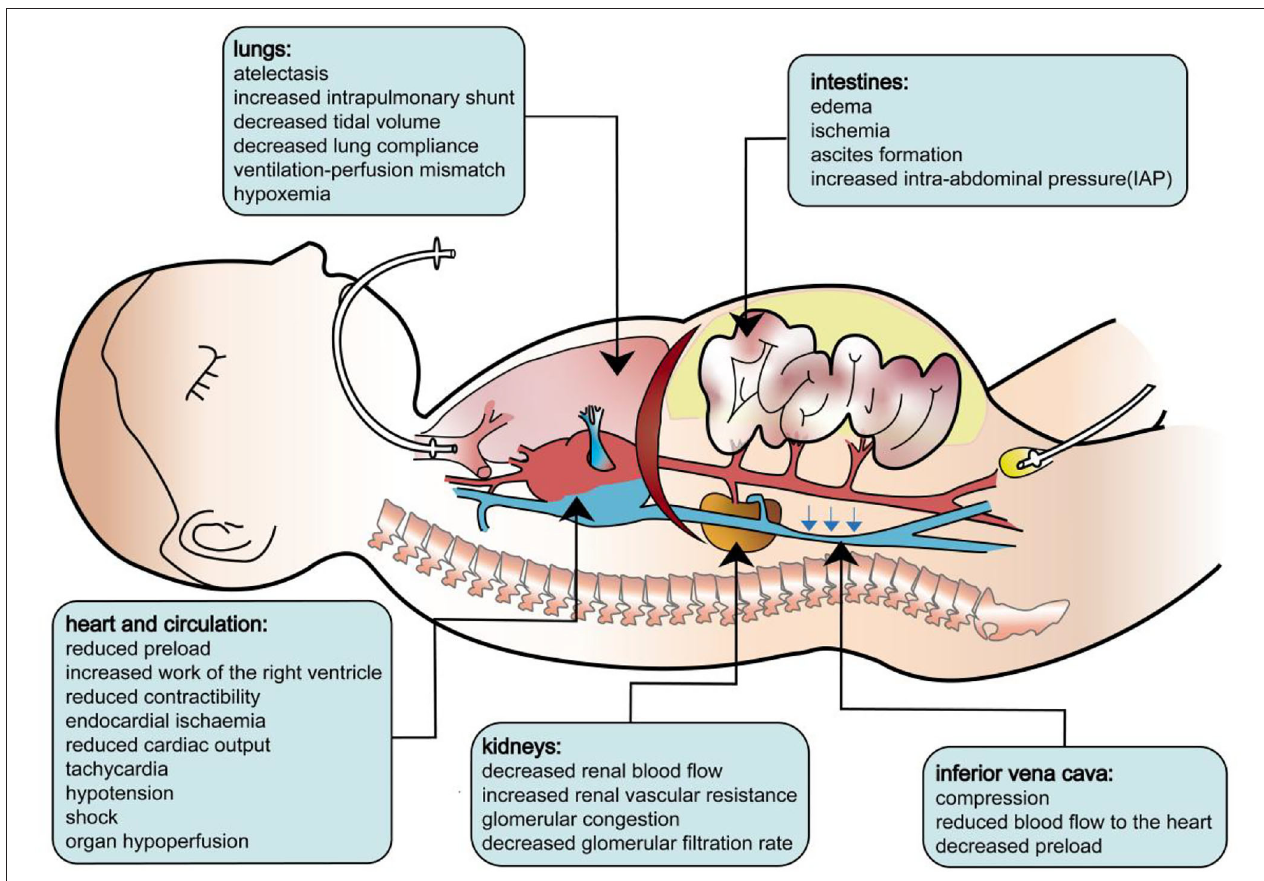
FIGURE 3 | Pathophysiology of abdominal compartment